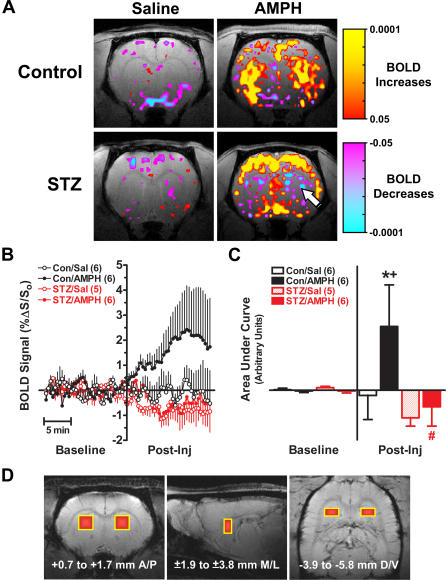
AMPH-Induced Striatal BOLD fMRI Responses Are Attenuated in STZ-Treated Rats(A) t-thresholded statistical maps (p < ±0.05 to p < ±0.0001; uncorrected comparisons of 15-min baseline period versus 15-min post-injection period) were constructed from subjects that best represent the BOLD signal activation within the DAT- and IR-enriched dorsal striatum. BOLD signal changes in response to saline (left panels) versus acute AMPH (right panels) within untreated control rats (top panels) versus STZ-treated rats (bottom panels). Compared to drug-naive animals given saline, AMPH [3 mg/kg, i.p.] elicited considerable BOLD activation in the dorsal striatum. This response was absent in drug-naive, STZ-pretreated hypoinsulinemic rats (arrow).(B) ROI analyses of striatal BOLD fMRI data for all subjects individually for each of the four treatment conditions in Panel A (n = 5–6).(C) Integration of fMRI time series data reveals significant group differences in BOLD activation within the dorsal striatal ROIs. One-way ANOVA (F
7,56 = 2.83, p < 0.05); Newman-Keuls (p < 0.05 compared to Baseline*, Saline+ and Control#).(D) Three-dimensional stereotaxic orientation of the striatal ROIs (1.88 × 1.88 × 1 mm) analyzed in (B and C). Shown at the bottom of each slice—representing axial, sagittal and coronal orientations—are the corresponding stereotaxic coordinates for the ROIs [68].